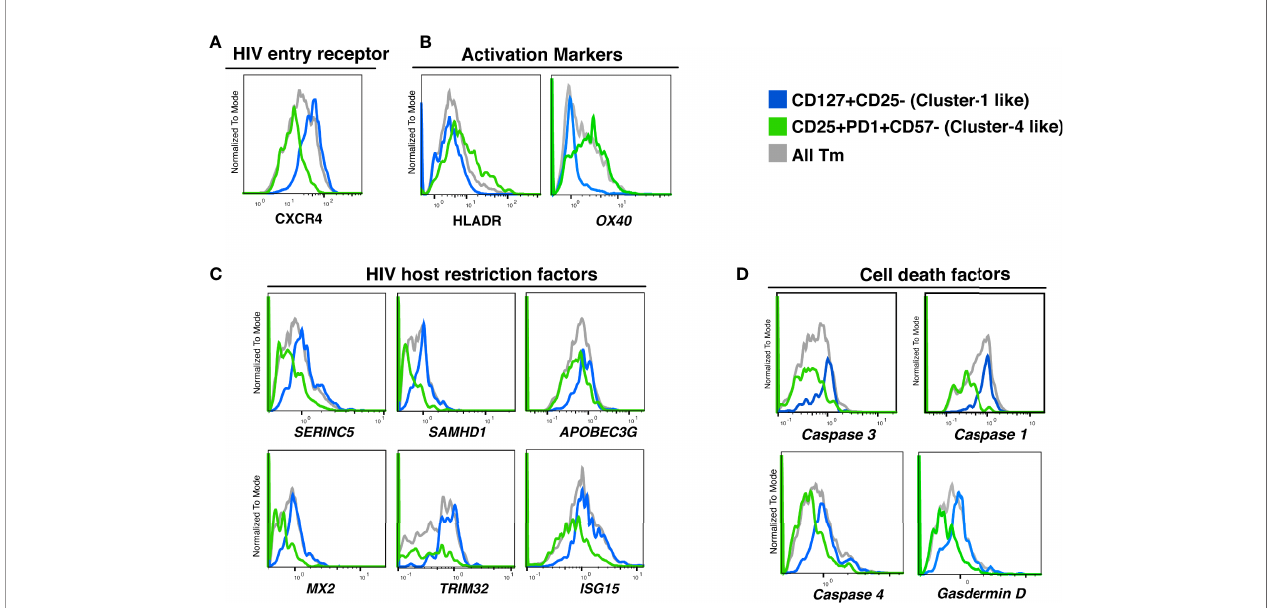
FIGURE 6 | Proteins and transcripts distinguishing CD4 Tm cells preferentially killed as bystander cells from CD4 Tm cells able to survive productive infection. (A – D) Histograms of the expression of (A) HIV entry receptors, (B) activation markers, (C) HIV host restriction factors, and (D) cell death related factors in CD127 +CD25- Tm (cluster 1-like, blue), CD25+PD1+CD57- Tm (cluster 4-like, green), and total Tm cells (grey). Names in italics indicate markers identi fi ed as transcripts. The data represented were collected from 2 donors in 2 independent